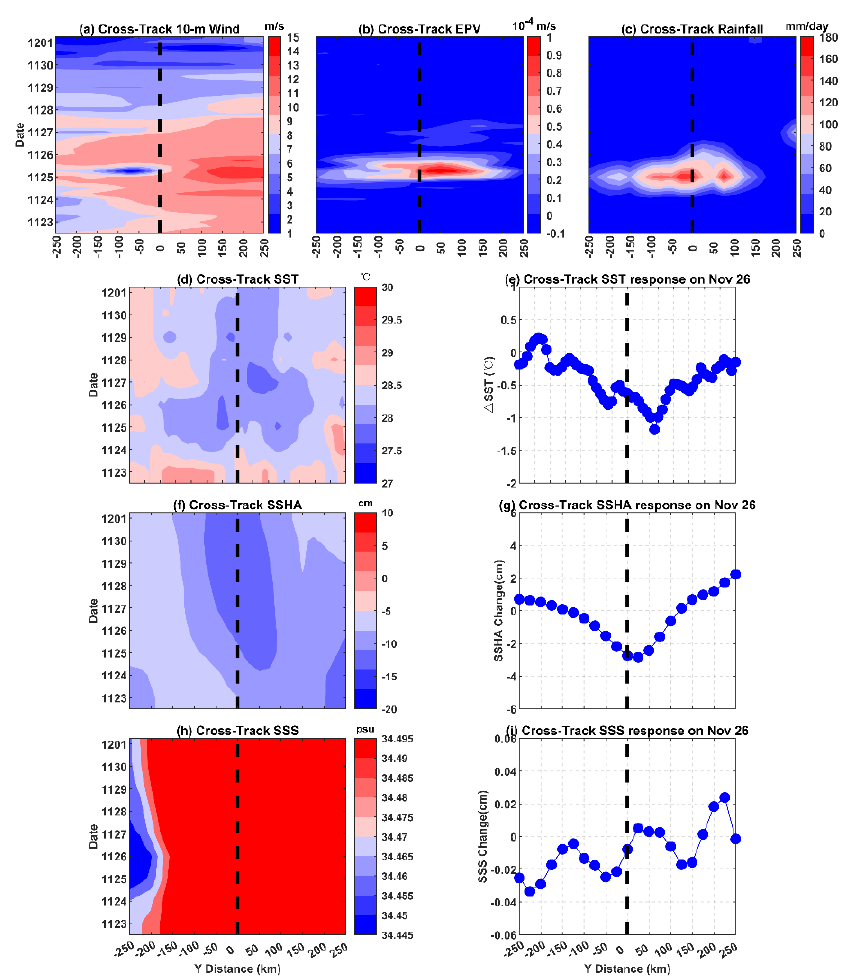
Figure 3. Temporal evolution of cross-track ( a ) SSW (shaded, m s −1 ), ( b ) cumulative Ekman pumping (shaded, m), and ( c ) cumulative rainfall (shaded, mm) at location 1 during the passage of typhoon Nida (23 November – 1 December 2009). ( d , e ) Temporal evolution of cross-track SST (shaded, °C) and the cross-track SST response on 26 November. ( f , g ) Temporal evolution of cross-track SSHA (shaded, cm) and the cross-track SSHA response on 26 November. ( h , i ) Temporal evolution of cross-track SSS (shaded, psu) and the cross-track SSS response on 26 November.